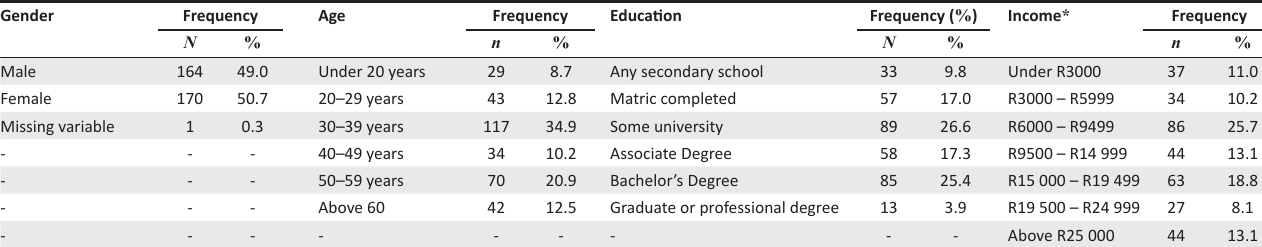
TABLE 1: Description of study